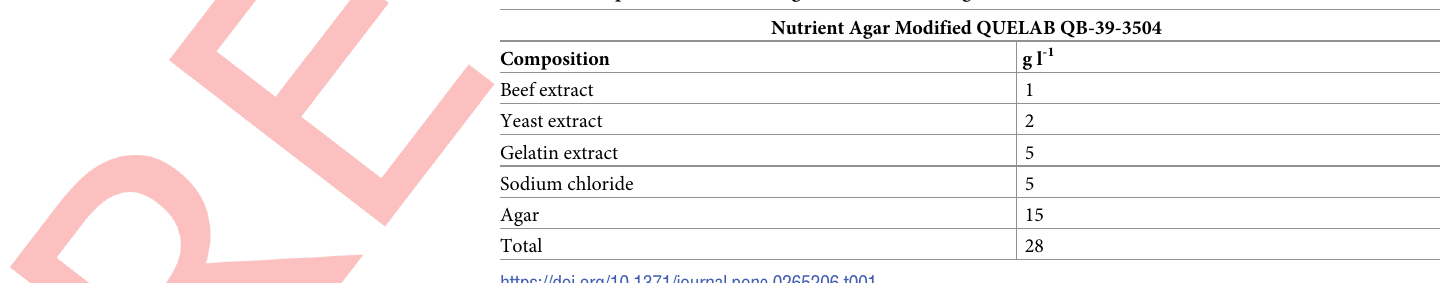
Table 1. Composition of nutrient agar used for culturing of the tested